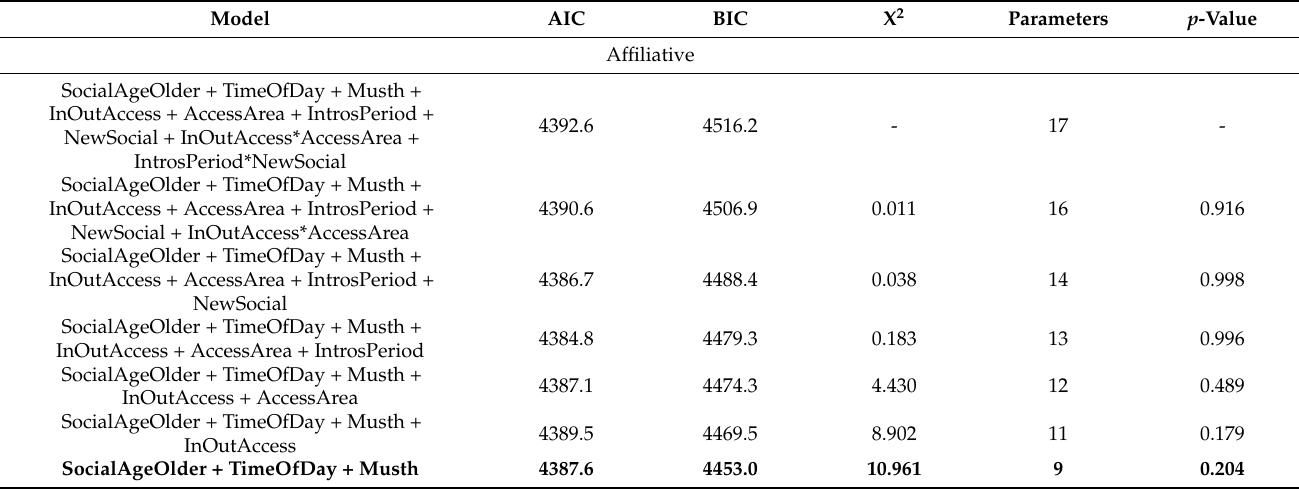
Table A2. Model selection table for GLMER of mature bull behaviors (mature focal data; bold indicates the final model selection). p -value from comparison to full model with